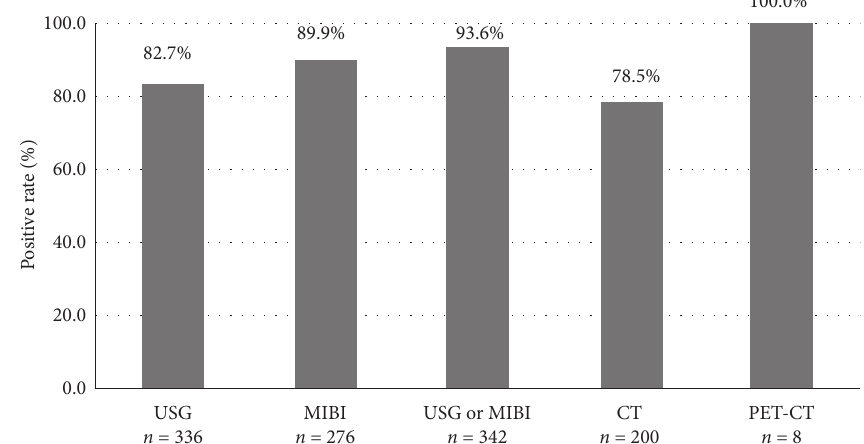
Figure 1: Positive rates in finding parathyroid lesions situated within the neck with different imaging methods. USG: cervical ultraso- nography; MIBI: 99m Tc-MIBI SPECT/CT; CT: cervical contrast-enhanced CT scan; PET-CT: 18F-FDG PET/CT; USG or MIBI: applied either the cervical ultrasonography or 99m Tc-MIBI SPECT/CT. Table 2: Sensitivity of different imaging methods in localizing parathyroid lesion in PHPT. Pathology (no.) Imaging (no.)